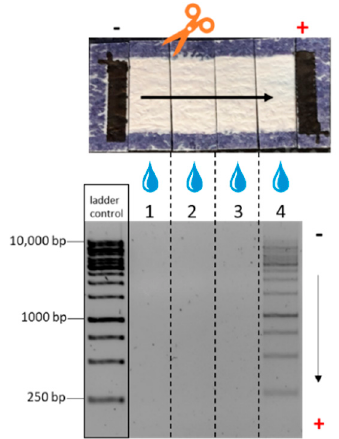
Figure 5. Fiber-based electrophoresis chip connected via imprinted electrodes and crocodile clamps to a voltage source. Upon the application of an electric field of 45 V, the sample migrated to the opposite electrode, verified by dividing and eluting of the chip area and visualized by gel electrophoresis. Each column on the agarose gel represents the eluted and loaded solution of one quarter of the chip area. As a control, the 1 kb ladder was loaded directly on the gel representing the initial sample